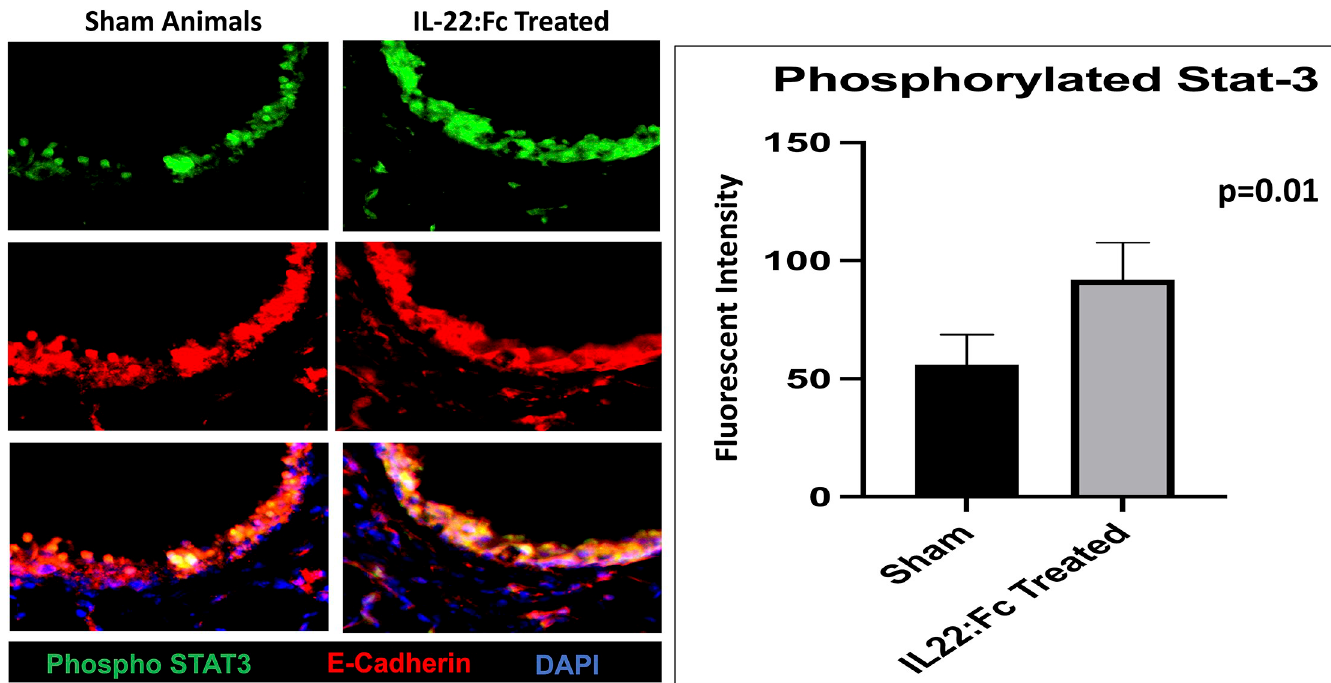
Fig 8. A comparison of the amount of phosphorylated-STAT-3 in low-dose LPS injured mice. The amount of phosphorylated-STAT-3 was not higher in the fk-652 treated animals in low-dose LPS injury (A and D). Representative images of the airways are shown in low-dose LPS injured for IL-22:Fc treated and sham animals. Representative images of the alveoli is shown in low-dose LPS injured for IL-22:Fc treated and sham animals.